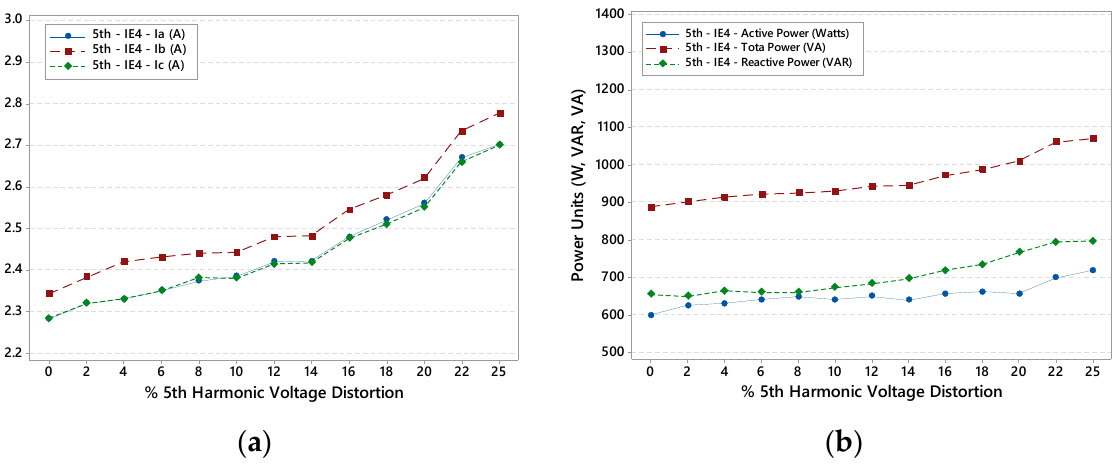
Figure 8. LSPMM in the presence of fifth voltage harmonic: ( a ) input line currents; ( b ) active, reactive and total Power.